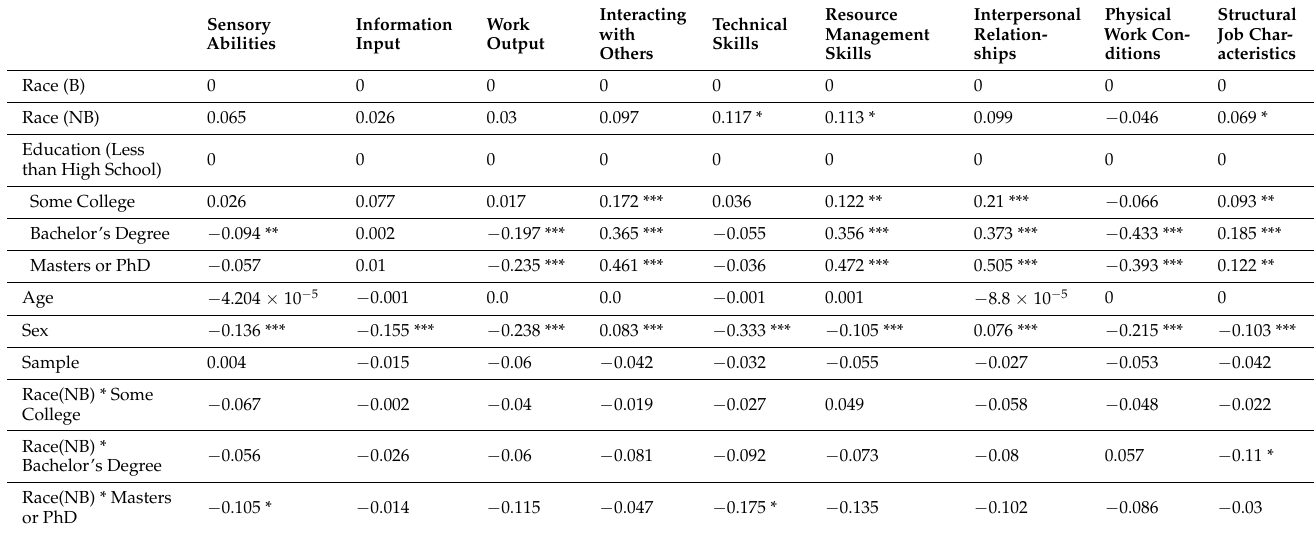
Table 2. Results from Generalized Estimating Equations investigating racial and educational variation in job characteristics, where Black race and Less than High School Education are the reference groups.